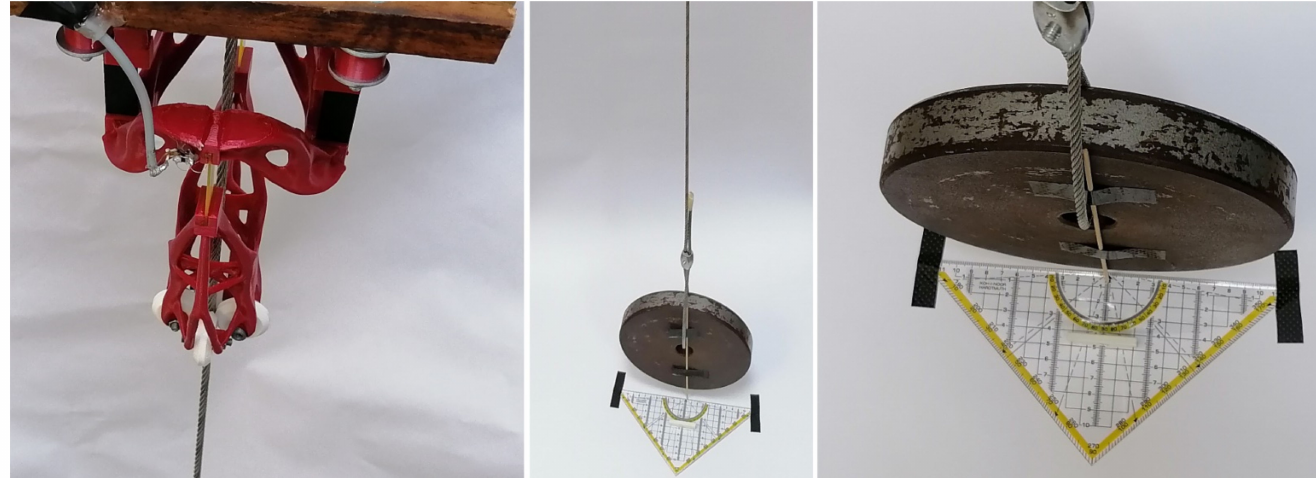
Figure 4. Measurement description: on the left, the sensing device; in the middle and on the right the detail on the ruler and pointer is shown.